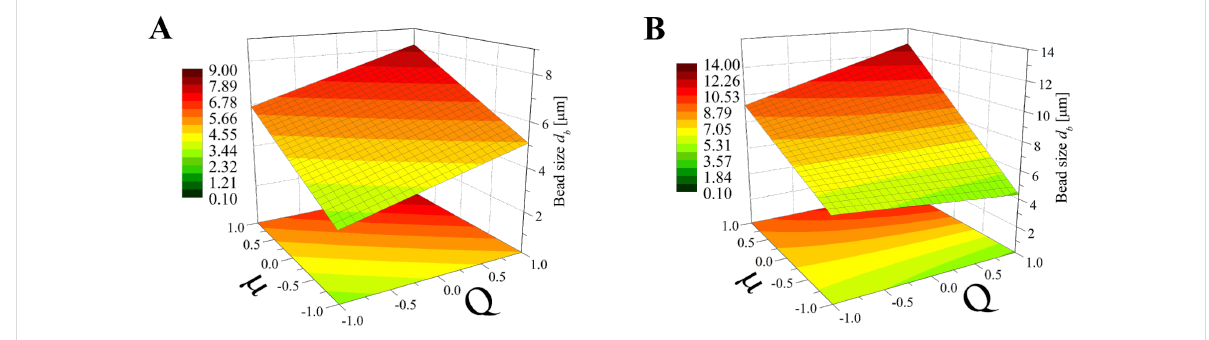
Figure 13: Response surface plots presenting the dependence of the size of obtained beads ( d b ) on the dynamic viscosity (µ) and the flow rate ( Q ) of the polymer solution for (A) minimum electrical voltage ( U = − 1) and (B) maximum electrical voltage ( U = 1) .